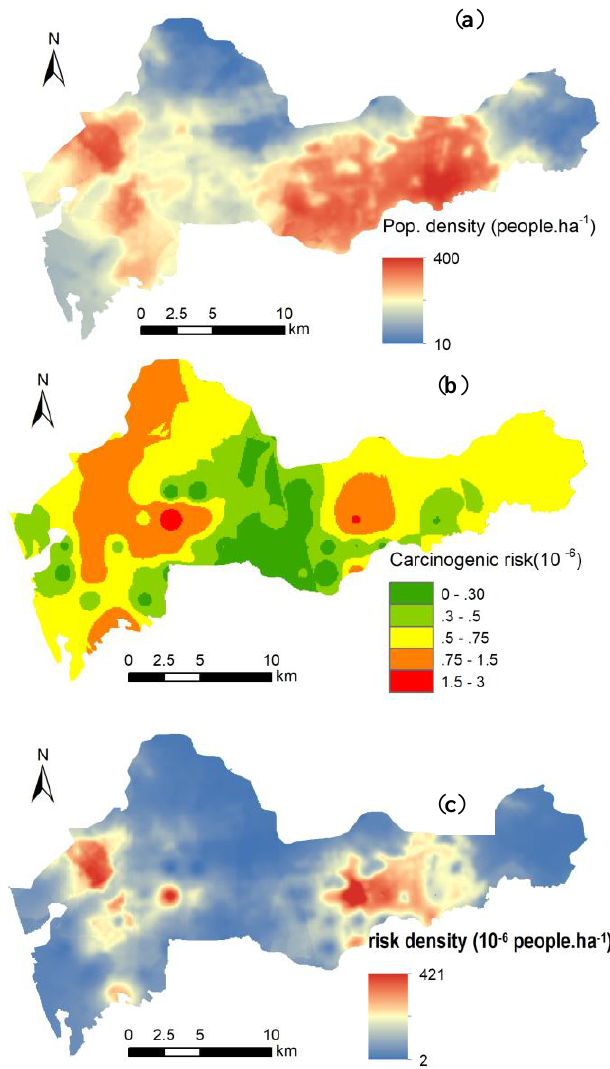
Figure 3. Maps of Location Based Service (LBS) and PAH risk distribution ( a ) Population density obtained from LBS, ( b ) Carcinogenic risk of PAHs and ( c ) Health risk density (HRD).